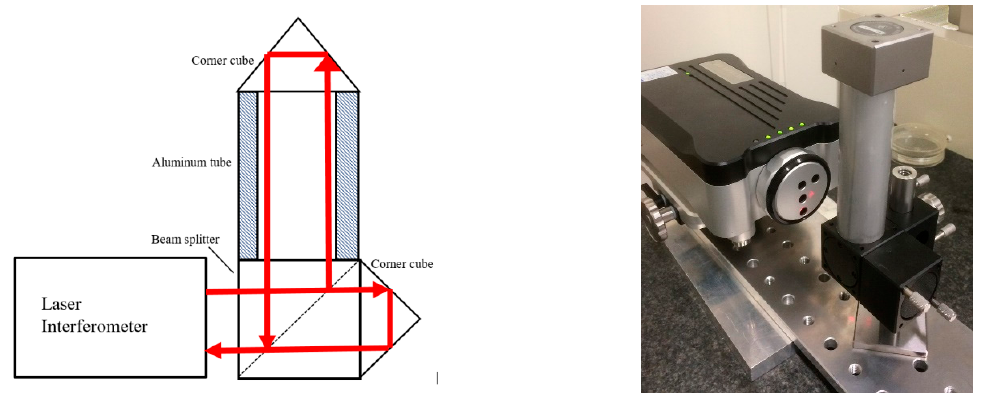
Figure 6. Schematic and picture of a set-up to determine interpolation errors by letting an aluminum tube cool down.